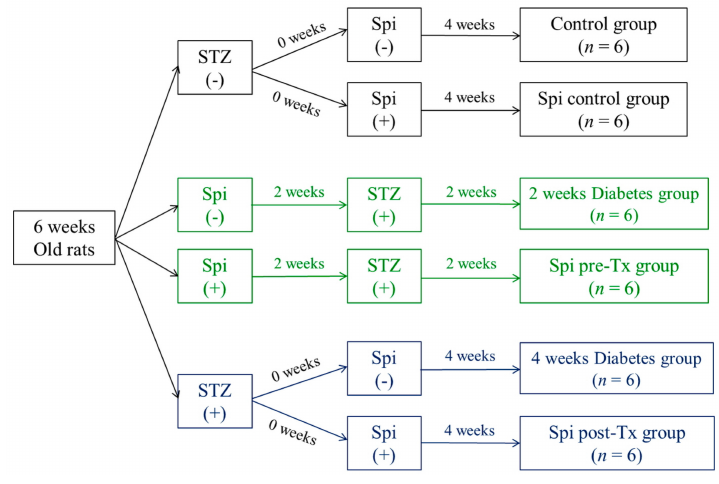
Figure 1. Schematic diagram of the in vivo experimental